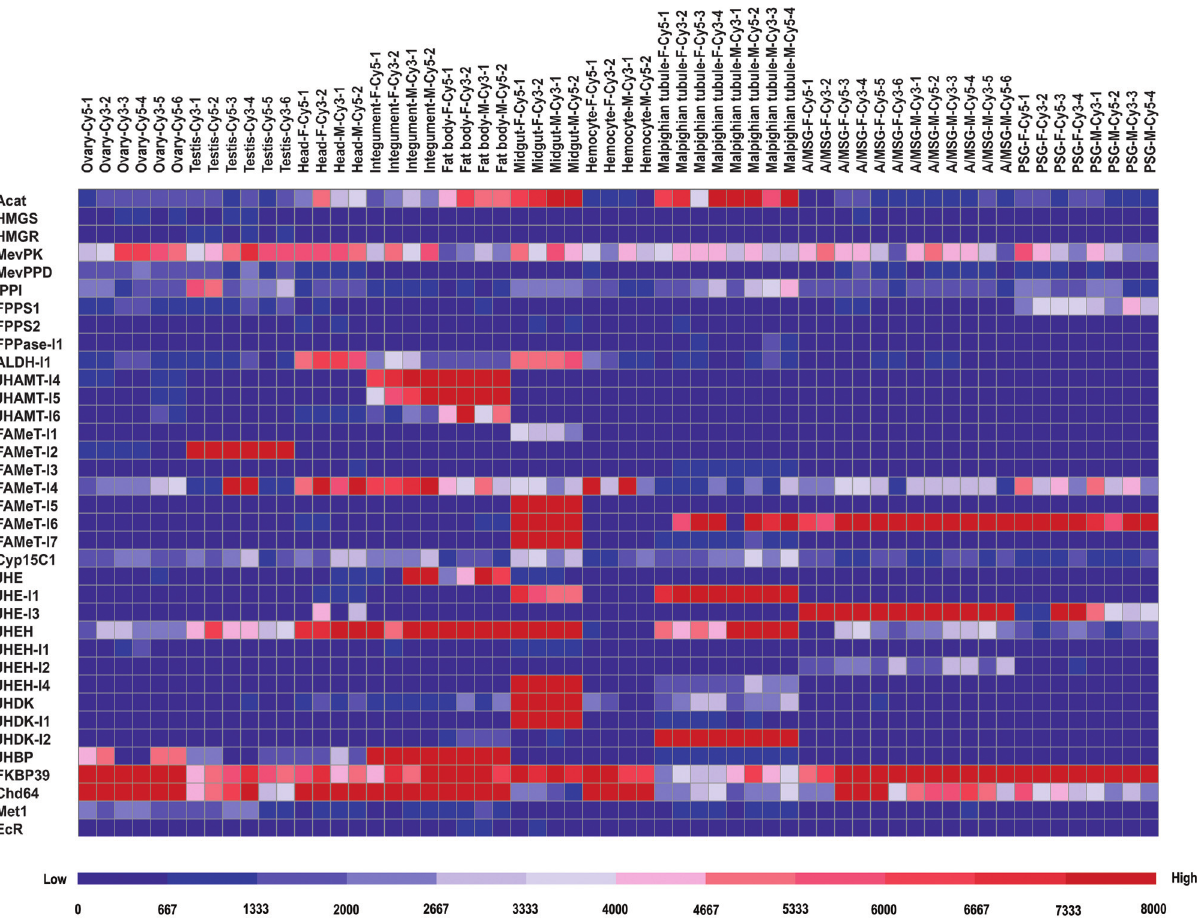
Figure 4 - Expression pattern of JH-related genes in multiple tissues from B. mori larvae. Microarray data of genome-wide gene expression in multiple tissues from B. mori larvae on the third day of the fifth instar were downloaded from the B. mori genome database. Each tissue sample was analyzed with atleasttwobiologicalrepeats.IfaJH-relatedgenewasestimatedtohaveanaverageexpressionsignalintensityofmorethan400inanytissue,itwascon- sidered to be expressed in that tissue. F, female; M, male. A/MSG, anterior/median silk gland; PSG, posterior silk